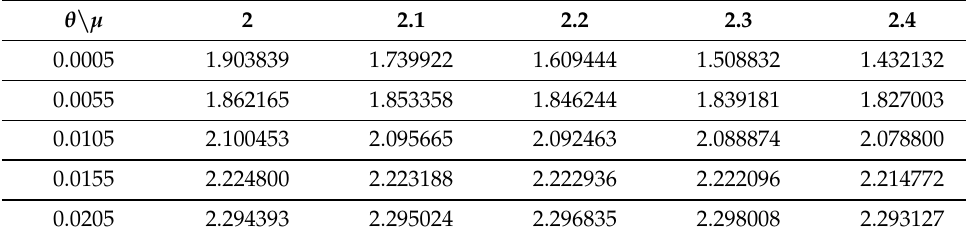
Table 2. Effect of θ vs µ on the waiting time of a customer in the queue ( Λ 3 ) . θ \ µ